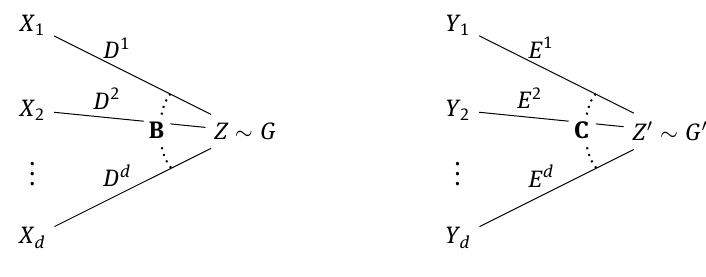
Figure 3 The setting in Section 4: completely specified factor models with dependence specifications D i and B = ( B t ) t as well as E i and C = ( C t ) t , 1 ≤ i ≤ d , and with factor distribution function G and G (cid:48) , respectively, such that Ran ( G ) = Ran ( G (cid:48) )